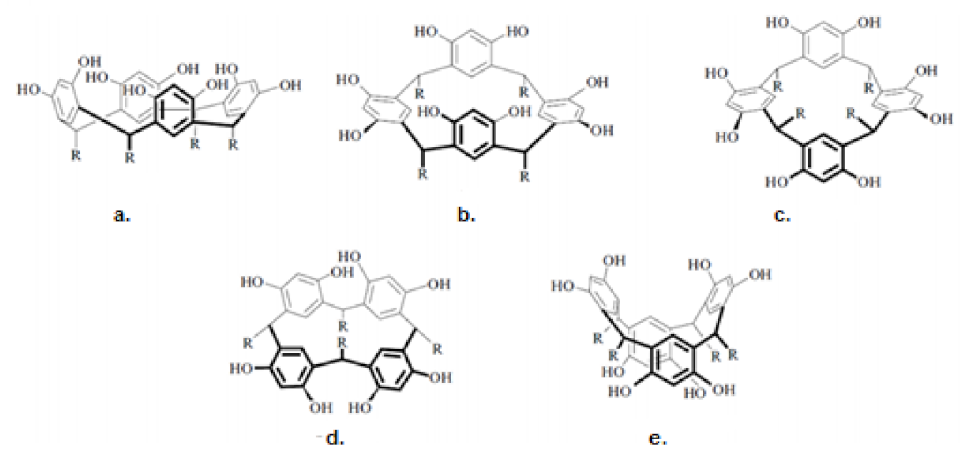
Figure 2. Conformations of calix[4]resorcinarenes: ( a ). Crown; ( b ). Boat; ( c ). Chair; ( d ). Diamond; ( e ).